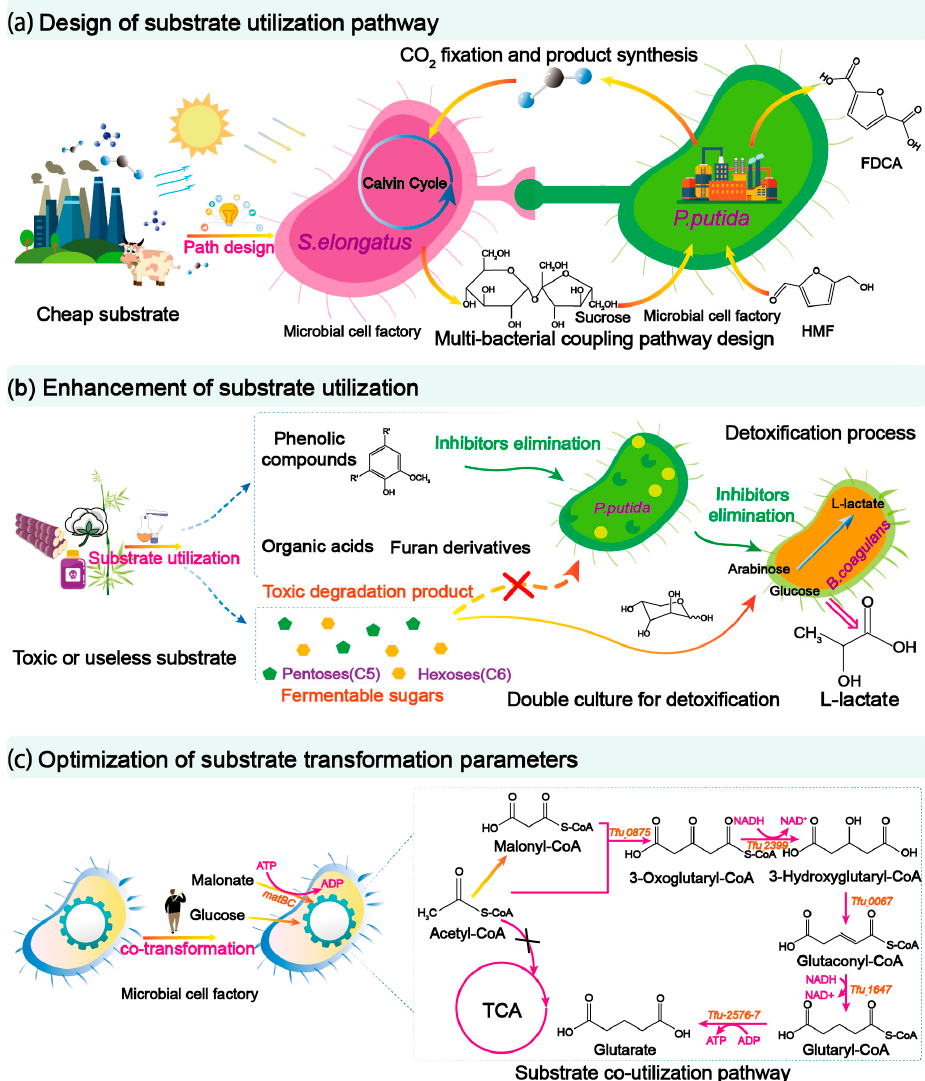
Figure 2. Strategies for efficient utilization of cheap substrates. ( a ) A multi-bacterial coupling pathway was designed for the utilization of substrates. S. elongatus was used for the fixation of CO 2 and the supply of sucrose, while P. putida used sucrose to synthesize 2,5-Furandicarboxylic acid to achieve the utilization of substrates. HMF, 5-hydroxymethylfurfural; FDCA, 2,5-Furandicarboxylic acid. ( b ) The toxic substrate is utilized through the two-bacterium co-culture system, and P. putida metabolizes the toxic substances in the hydrolysate, promoting the efficient synthesis of L-lactate by B. coagulans , to achieve the detoxification treatment of the toxic substrate and microbial synthesis. ( c ) By designing the co-utilization of malonate and glucose, the efficient synthesis of glutarate can be